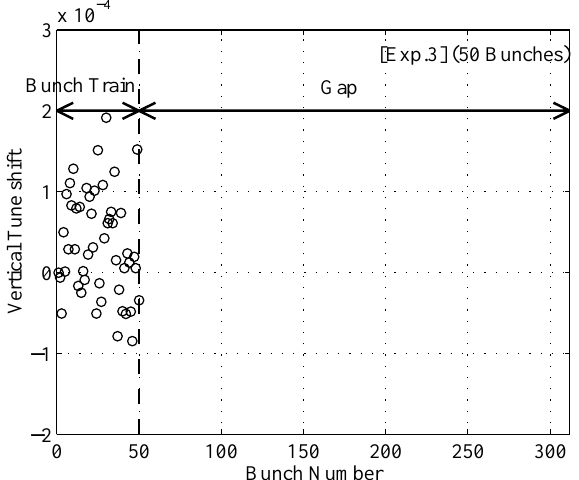
FIG. 6. Vertical tune shifts of individual bunches along the bunch train with 50